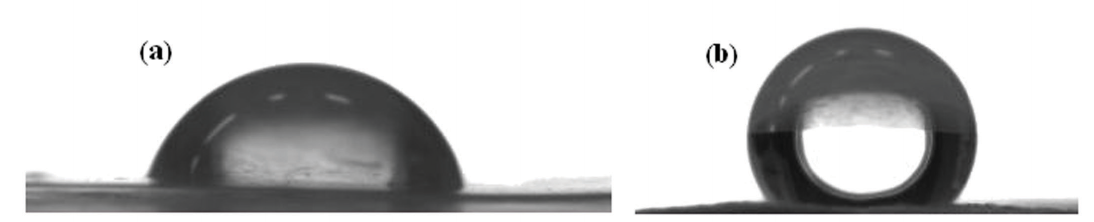
Figure 10. Shape of water drop on the air side of: (a) PHB film (θ=77.10Æ) and (b) PHB nanofibers mat